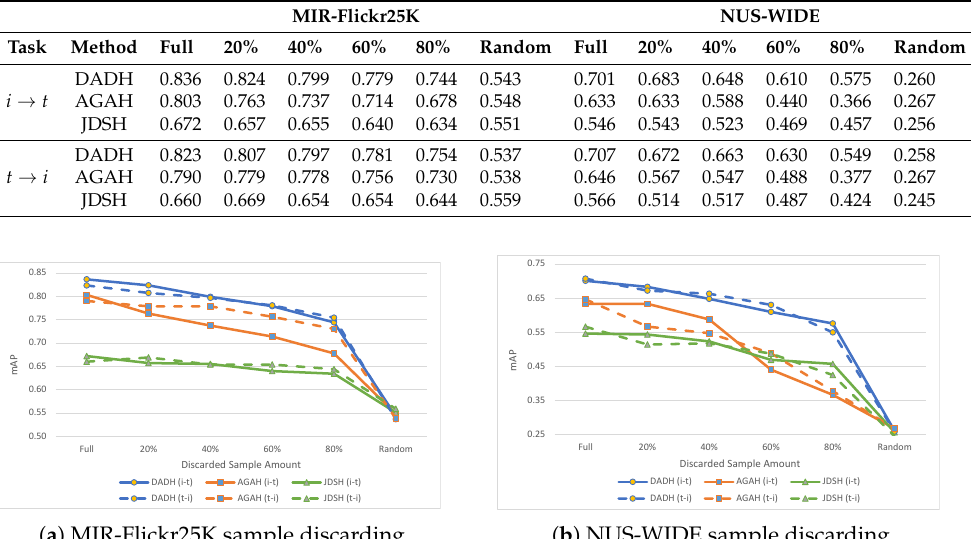
Table 6. Results (mAP) on MIR-Flickr25K and NUS-WIDE with sample discarding, i.e., training set being reduced. Column ‘Full’ shows results when training with full training set without any sample discarding. Subsequent columns show results with decreasing amounts of samples, where the given percentage denotes the percentage of samples in the training set which have been discarded. The ‘Random’ column holds the baseline random performance values. MIR-Flickr25K NUS-WIDE Task Method Full 20%